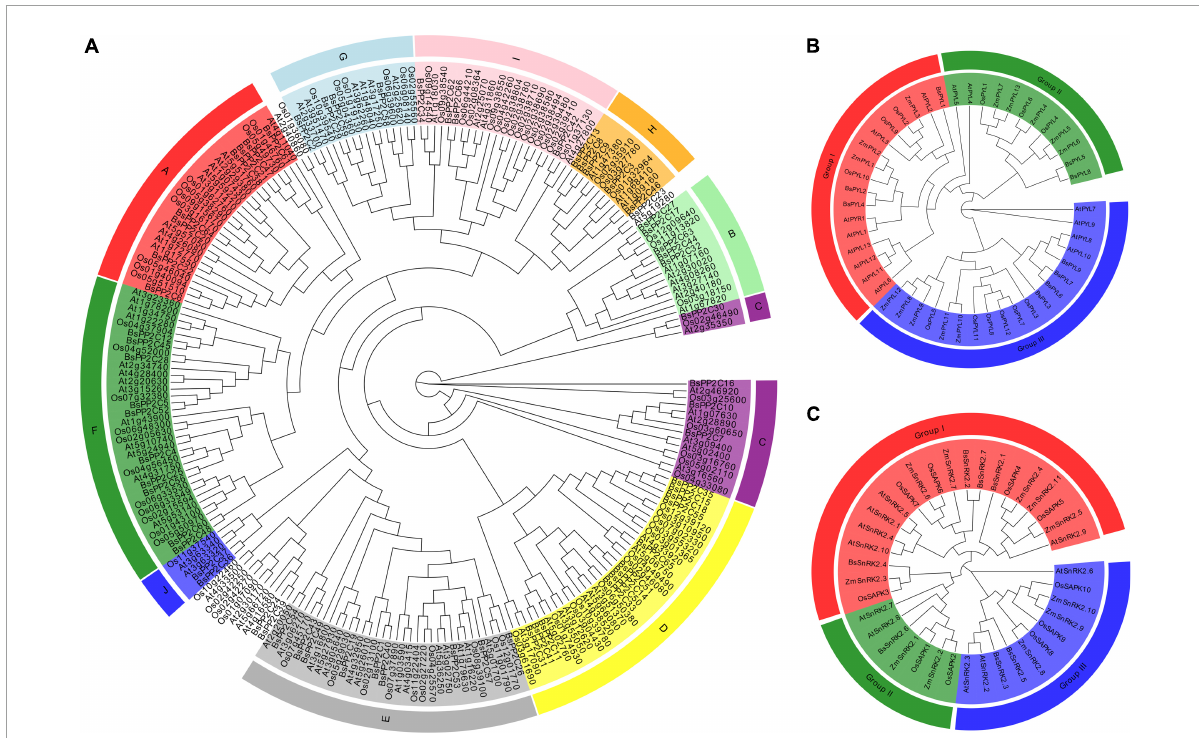
FIGURE1 Phylogenetic trees of PP2Cs, PYLs, and SnRK2s gene families. (A) The maximum likelihood tree of PP2Cs include 78 members from A. thaliana (At), 80 members from O. sativa (Os), and 66 members from B. striata (Bs). The maximum likelihood tree of PYLs (B) and SnRK2s (C) gene families in A. thaliana (At), O. sativa (Os), Z. mays (Zm), and B. striata (Bs). The ML phylogenetic trees were constructed using IQ-tree software with 1000 replicates. Different leaf background colors indicate the different